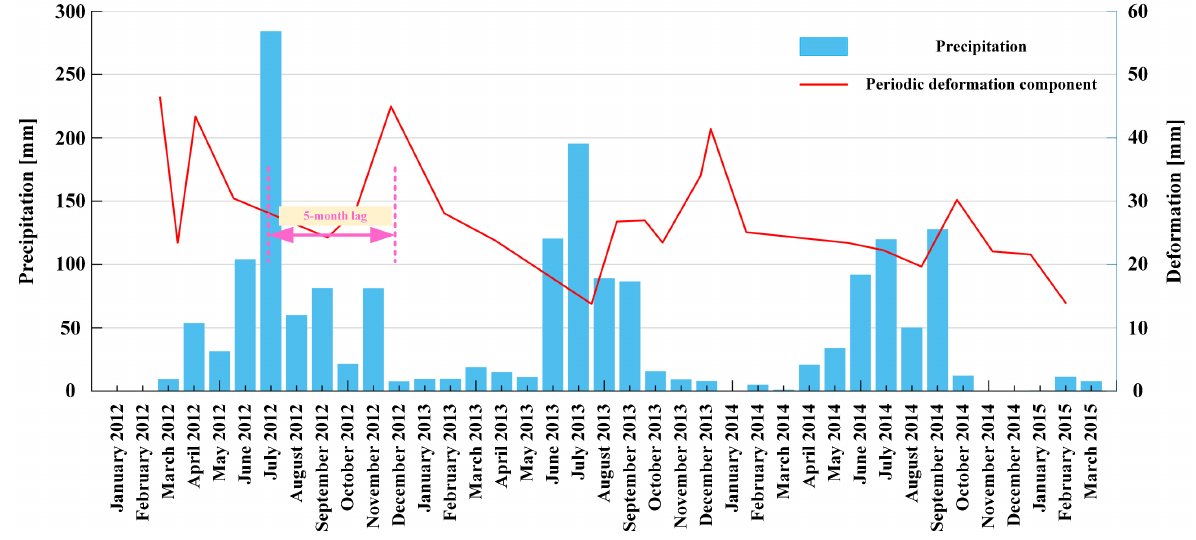
Figure 6. Correlation analysis between the periodic deformation components and precipitation.